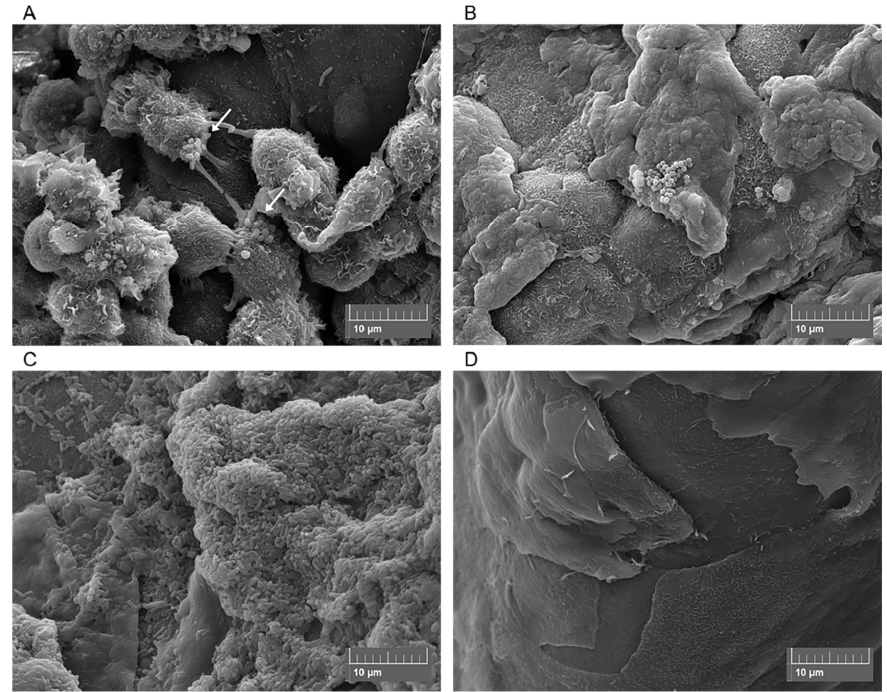
Figure 3. Scanning electron micrographs of ex vivo porcine corneas after 4 h Methicillin-Resistant Staphylococcus aureus (MRSA) infection ( A ), 6 h MRSA infection ( B ), 24 h Pseudomonas aeruginosa infection ( C ) and the uninfected porcine cornea ( D ). Arrows show MRSA adhering to corneal epithelial cells. Existing In Vivo Infection